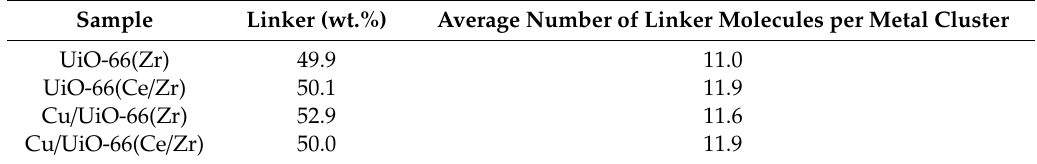
Table 3. The amount of linker in the sample and the average number of linker molecules coordinated to one metal cluster—calculated from TGA.